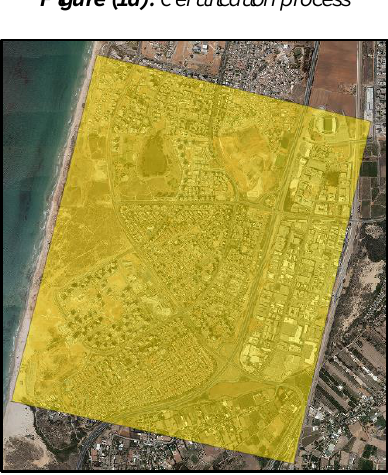
Figure (1b) : Certification test field, Netanya